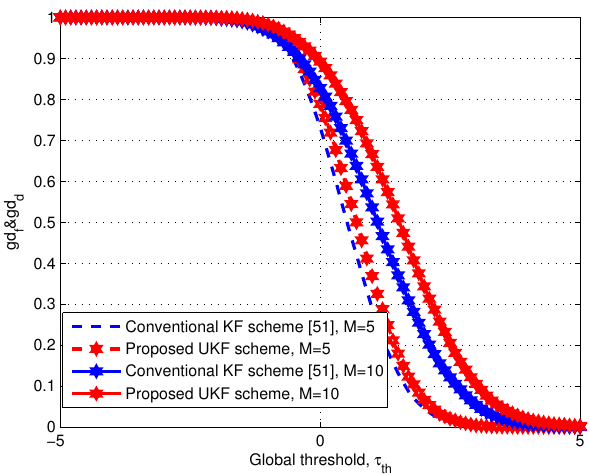
Figure 11. Performance comparison between Kalman filter (KL) and unscented Kalman filter (UKF) with different numbers of CUs.